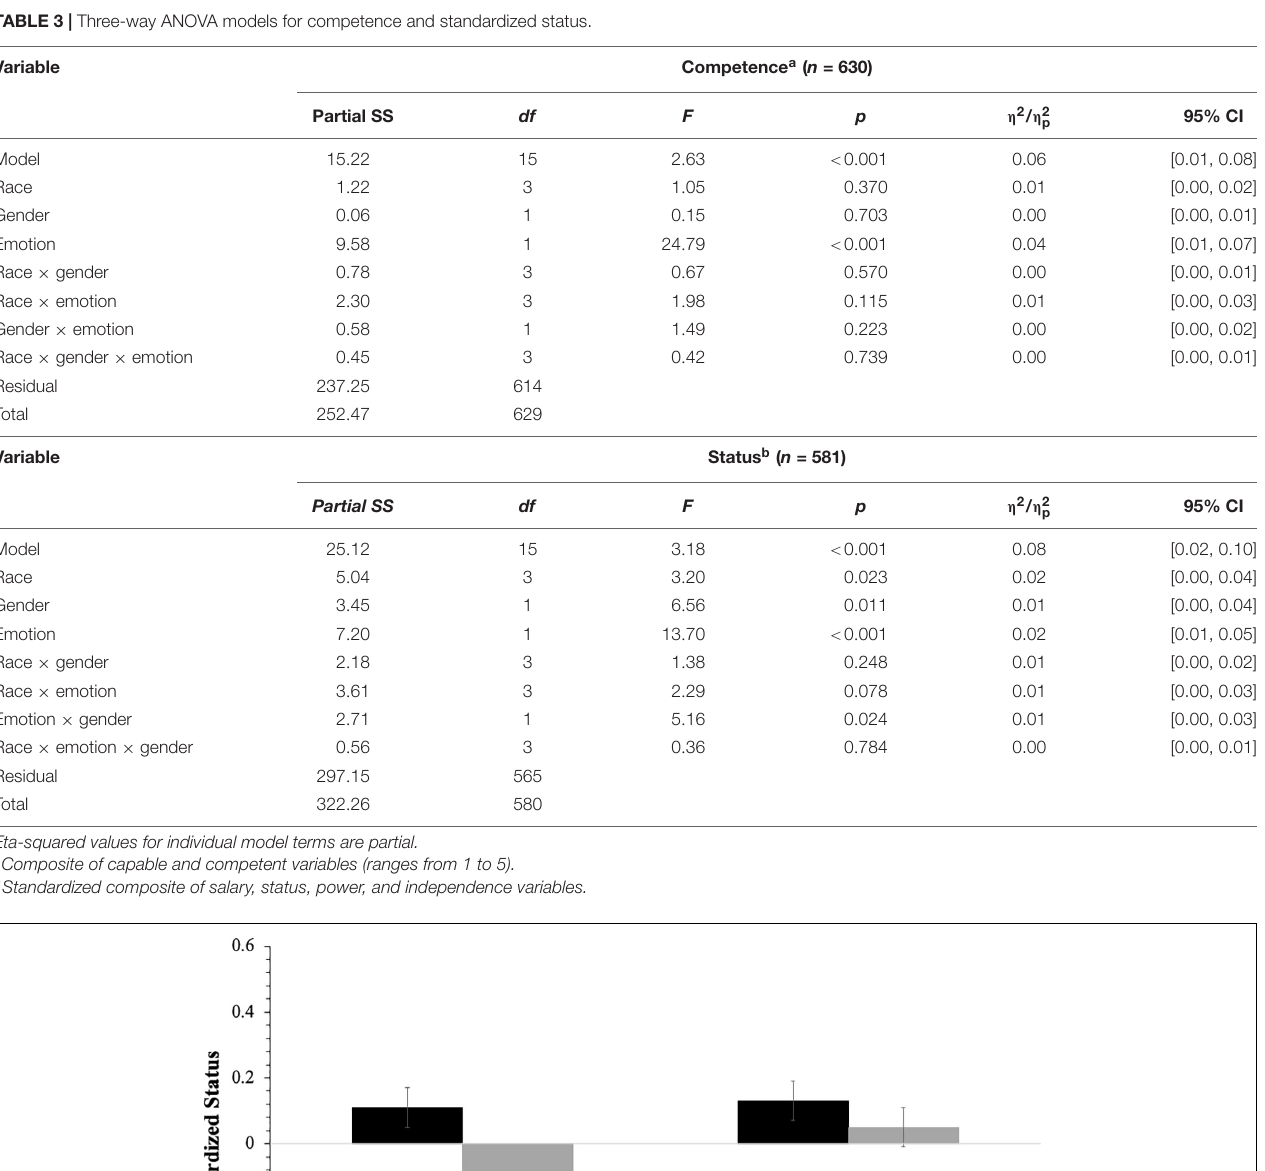
in three separate Bonferroni corrected ANOVA models and examined potential pairwise differences (see Figure 2 ). For